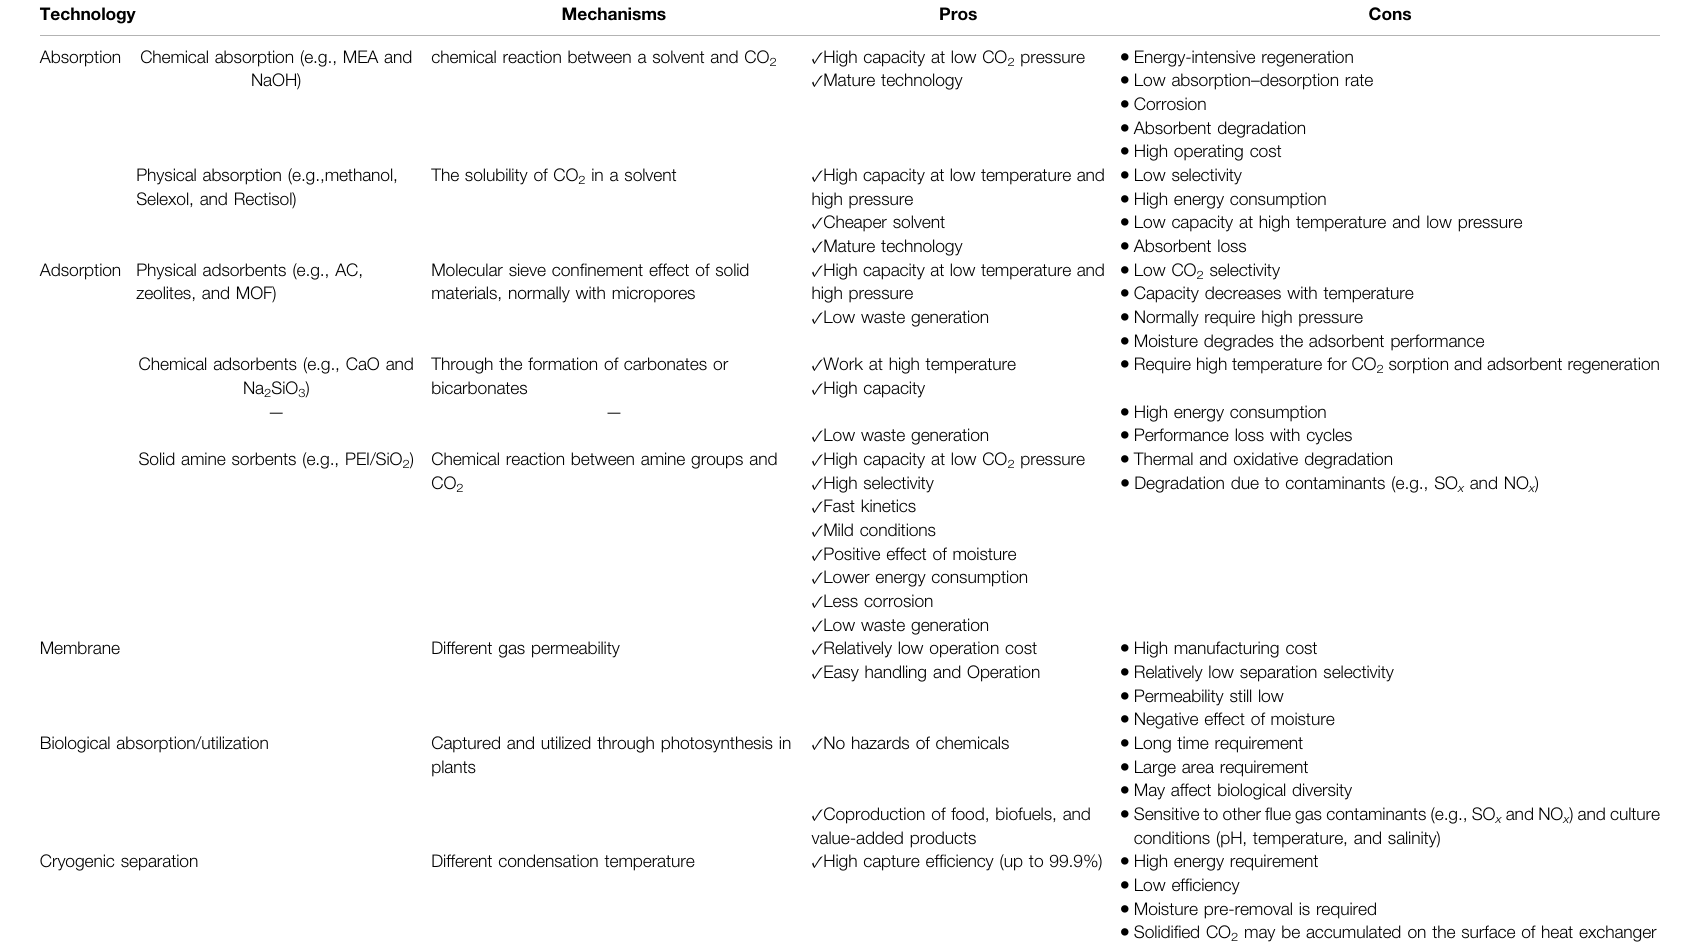
TABLE 3 | Comparison of typical CO 2 capture